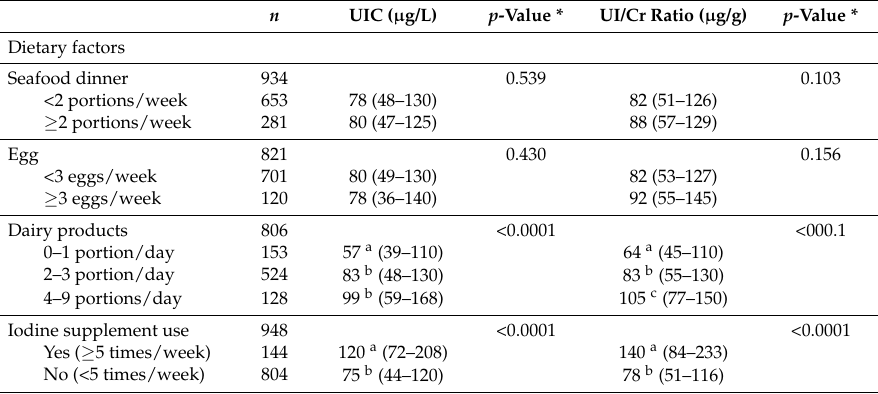
Table 3. Urinary iodine concentration ( µ g/L (UIC)) and urinary iodine to creatinine ratio ( µ g iodine/g creatinine (UI/Cr ratio)) according to selected maternal dietary intake given as median with 25th and 75th percentiles in the study